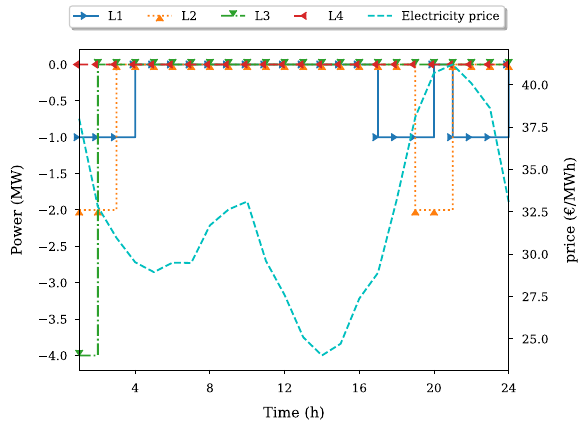
Fig. 4 Optimal scheduling for flexible loads in case